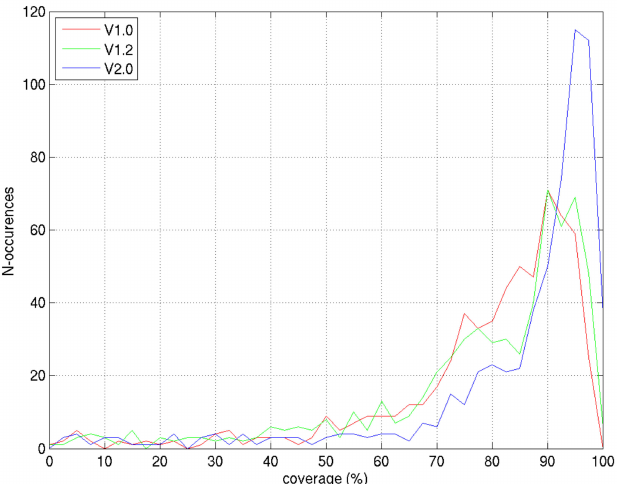
Figure 12. Histograms of the bulk coverage statistics of each of the three cBathy versions.